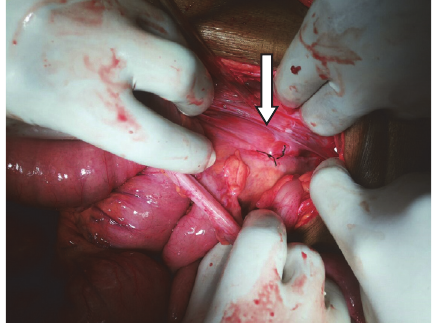
Figure 3: The repaired hernia defect after primary closure with nonabsorbable suture. White arrow refers to the repaired primary hernia